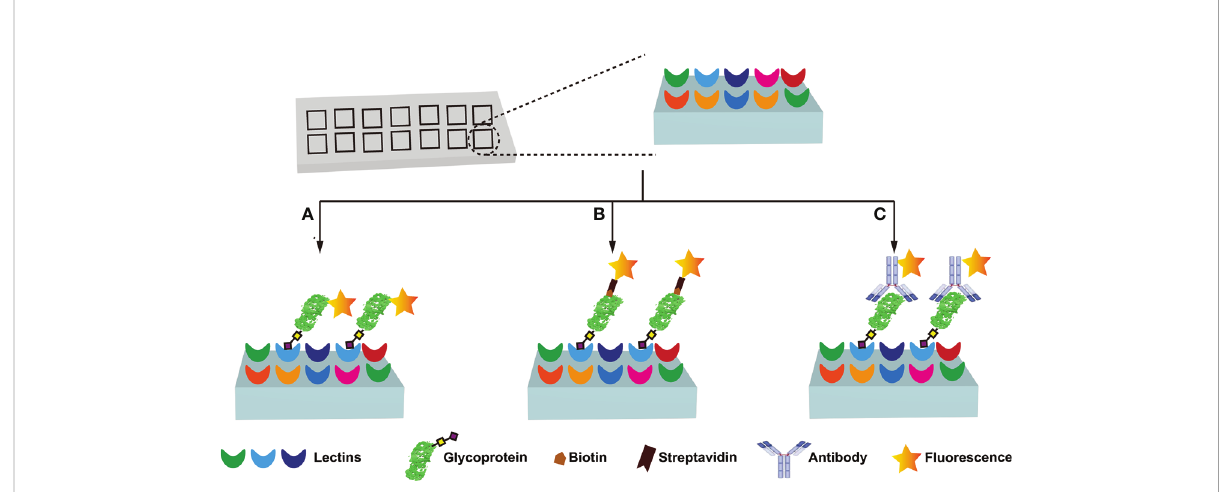
FIGURE 4 Lectin microarray analysis of protein glycosylation. Three main types of lectin microarray are used: fl uorescent labeling of glycoproteins (A) , biotin labeling of glycoproteins (B) , and antibody recognition of glycoproteins (C)